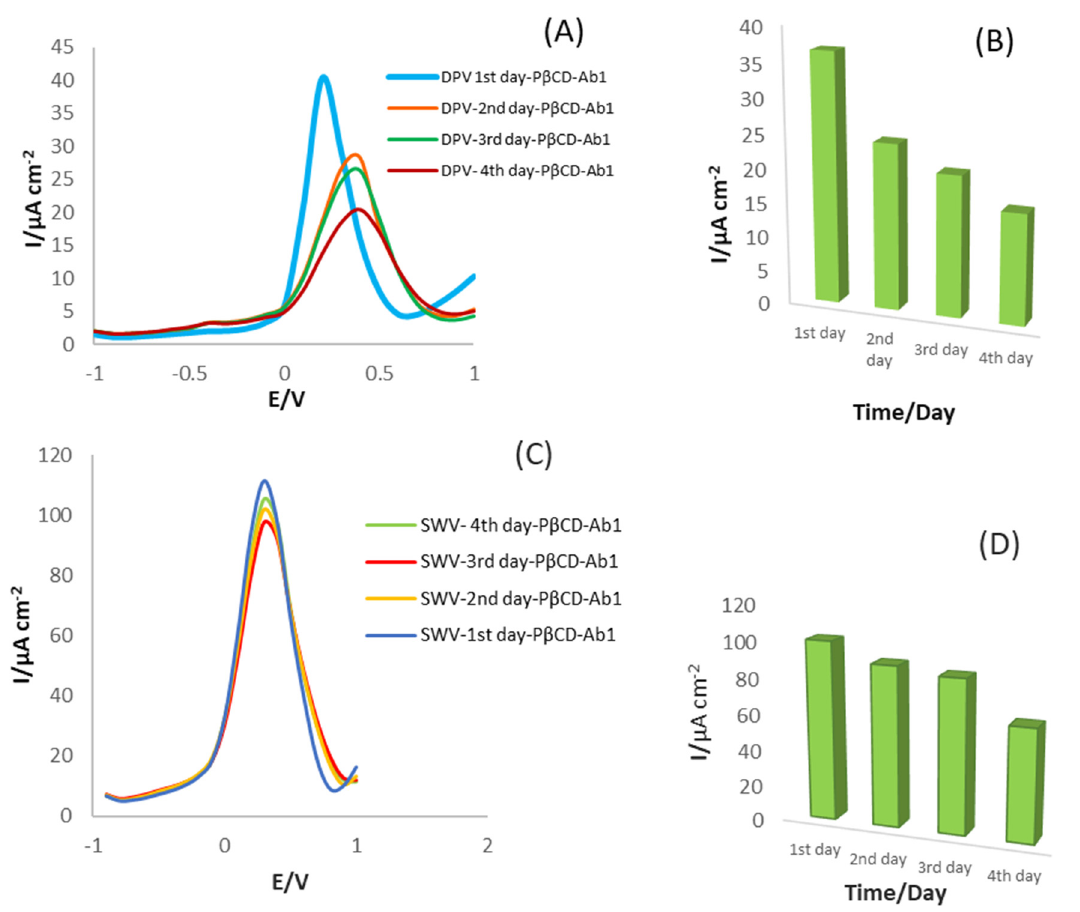
Figure 4. ( A ) DPV graphs of the P( β -DC)/Ab1-modified GCE at different storage times (1 to 4 days) in 0.03 M K 4 Fe(CN) 6 /K 3 Fe(CN) 6 /KCl as a supporting electrolyte with the potential range of − 1 to